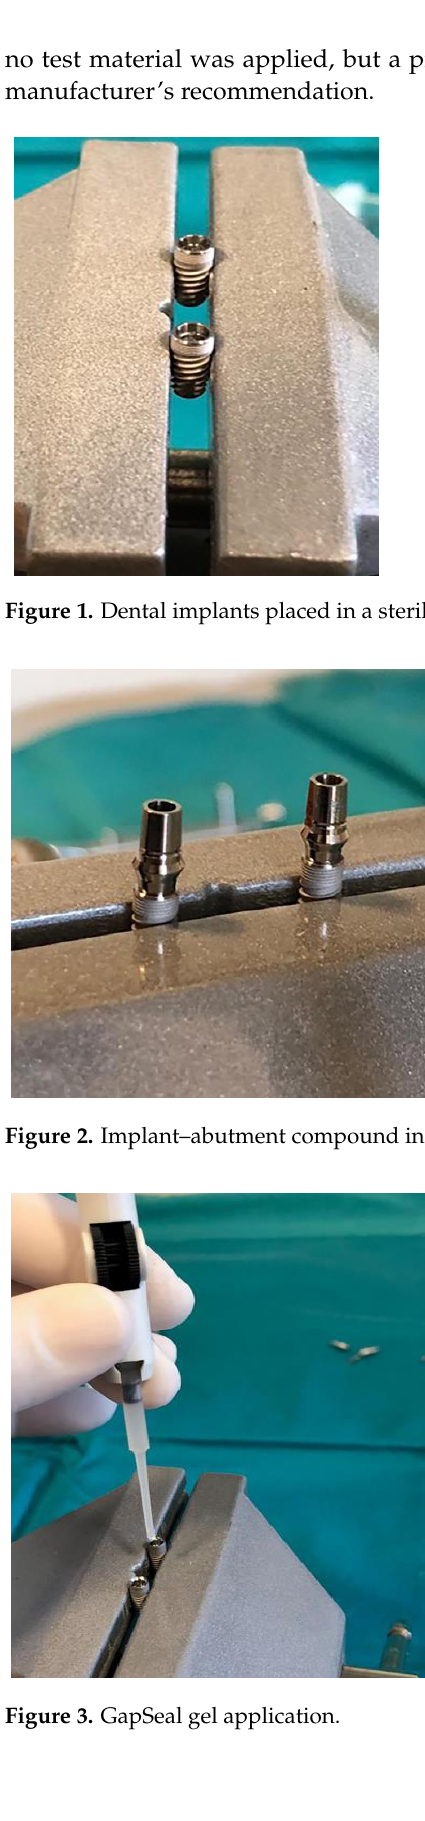
Figure 4. Oxysafe gel application. Figure 5. Flow.sil application.